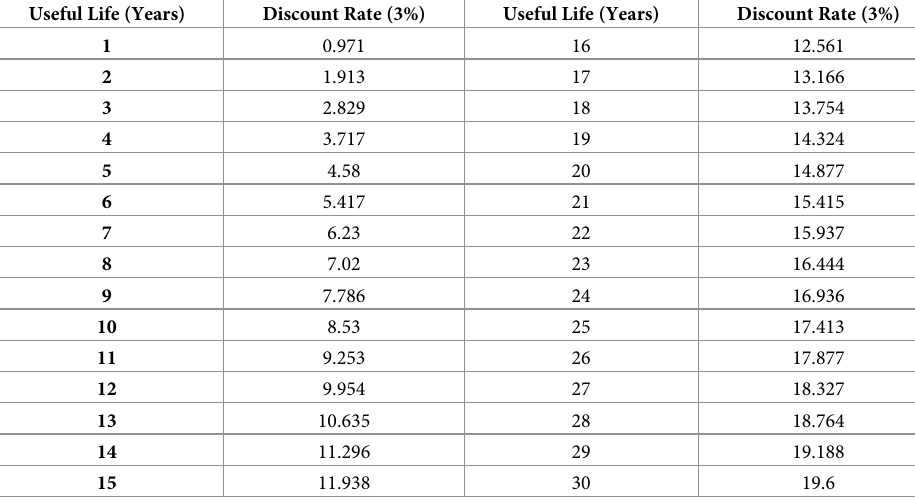
Table 1. Annualization factors a